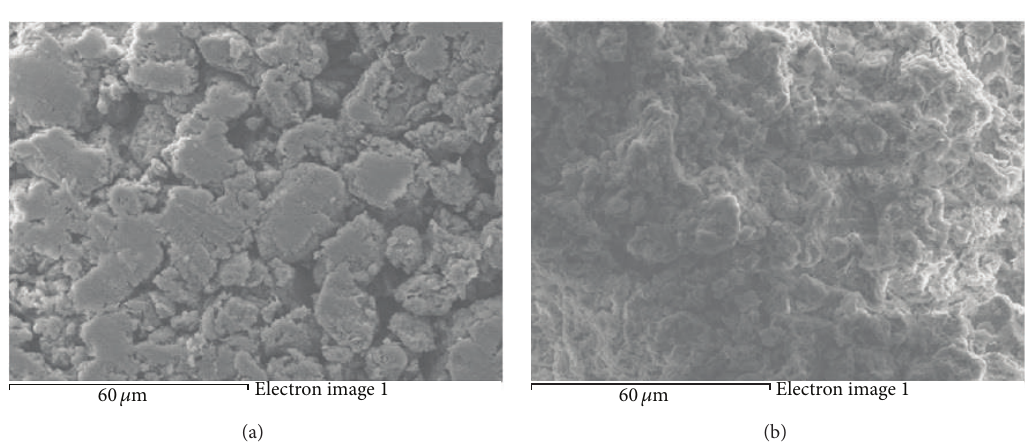
Figure 3: SEM micrographs of (a) CCB before adsorption and (b) CCB after adsorption.